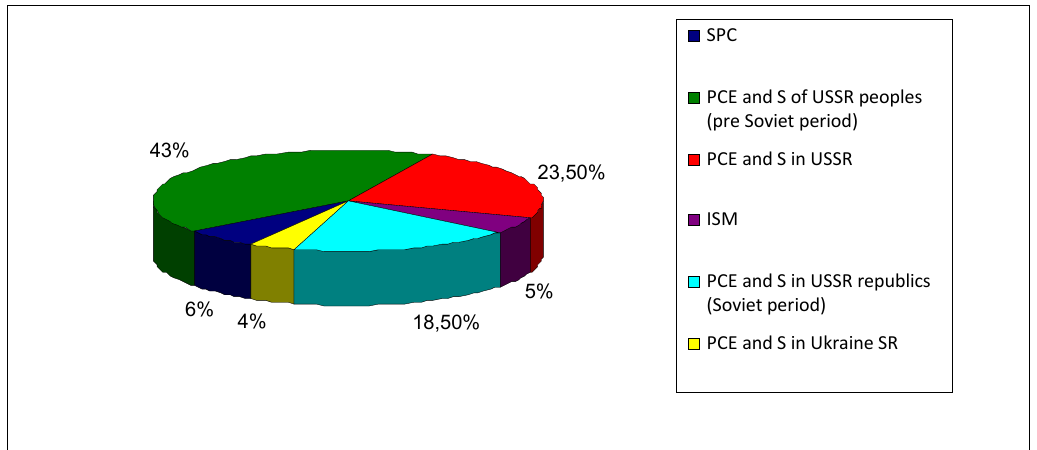
Fig.2. Historic directions of dissertation researches in 1939-1965